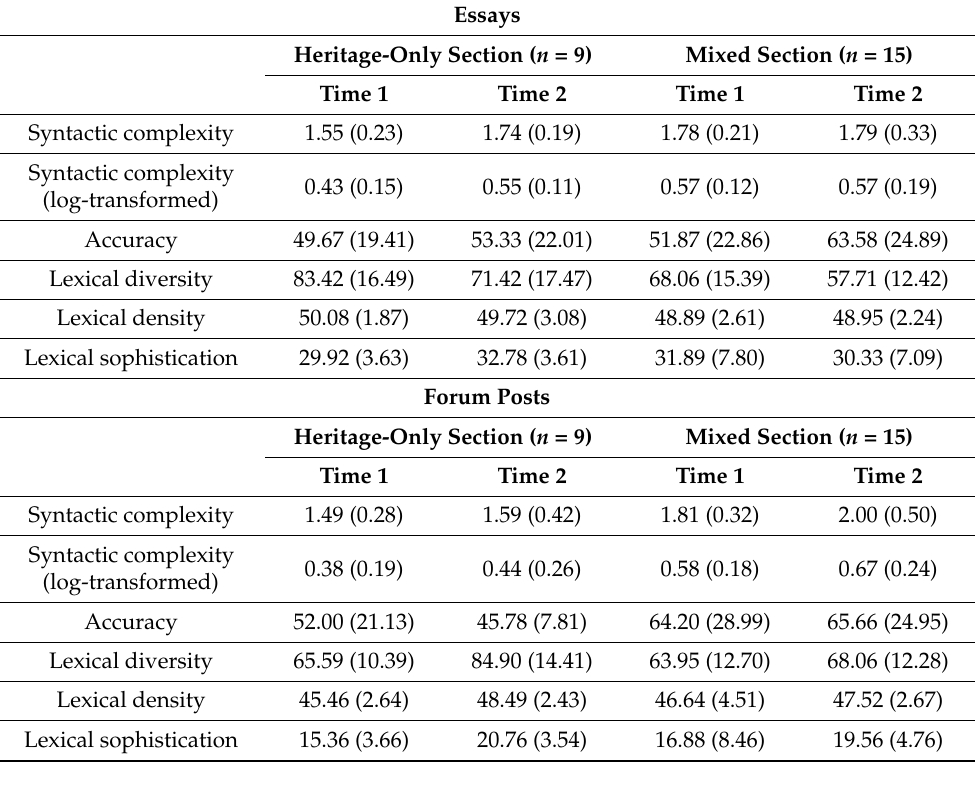
Table 2. Descriptive statistics for all writing measures (means and